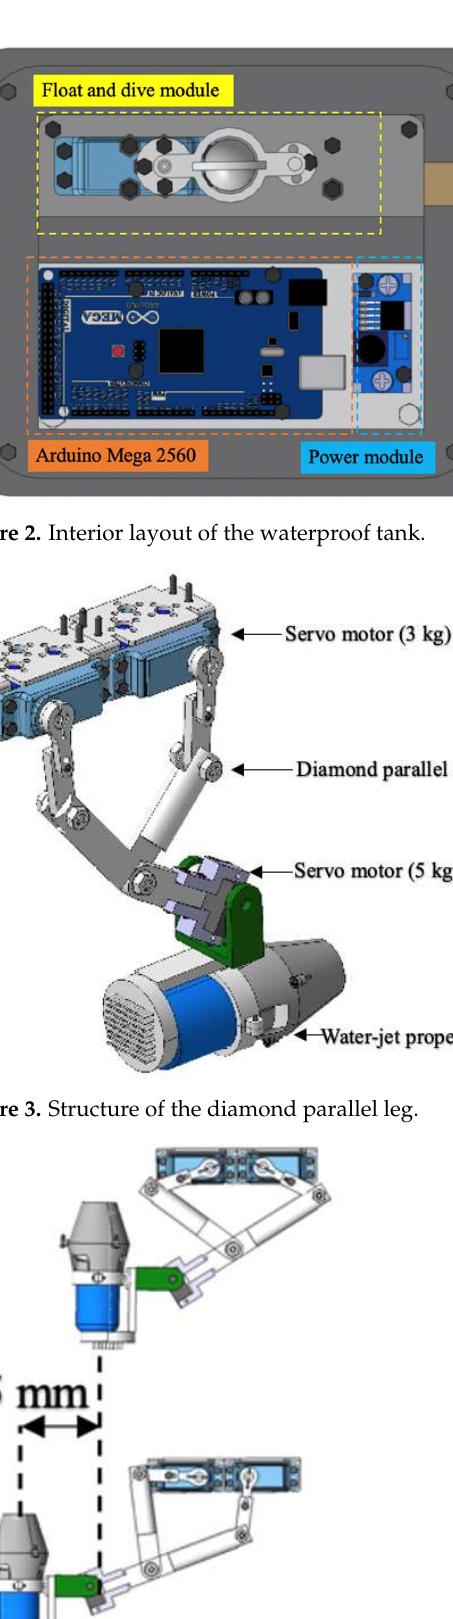
Figure 4. Distance of a step movement.